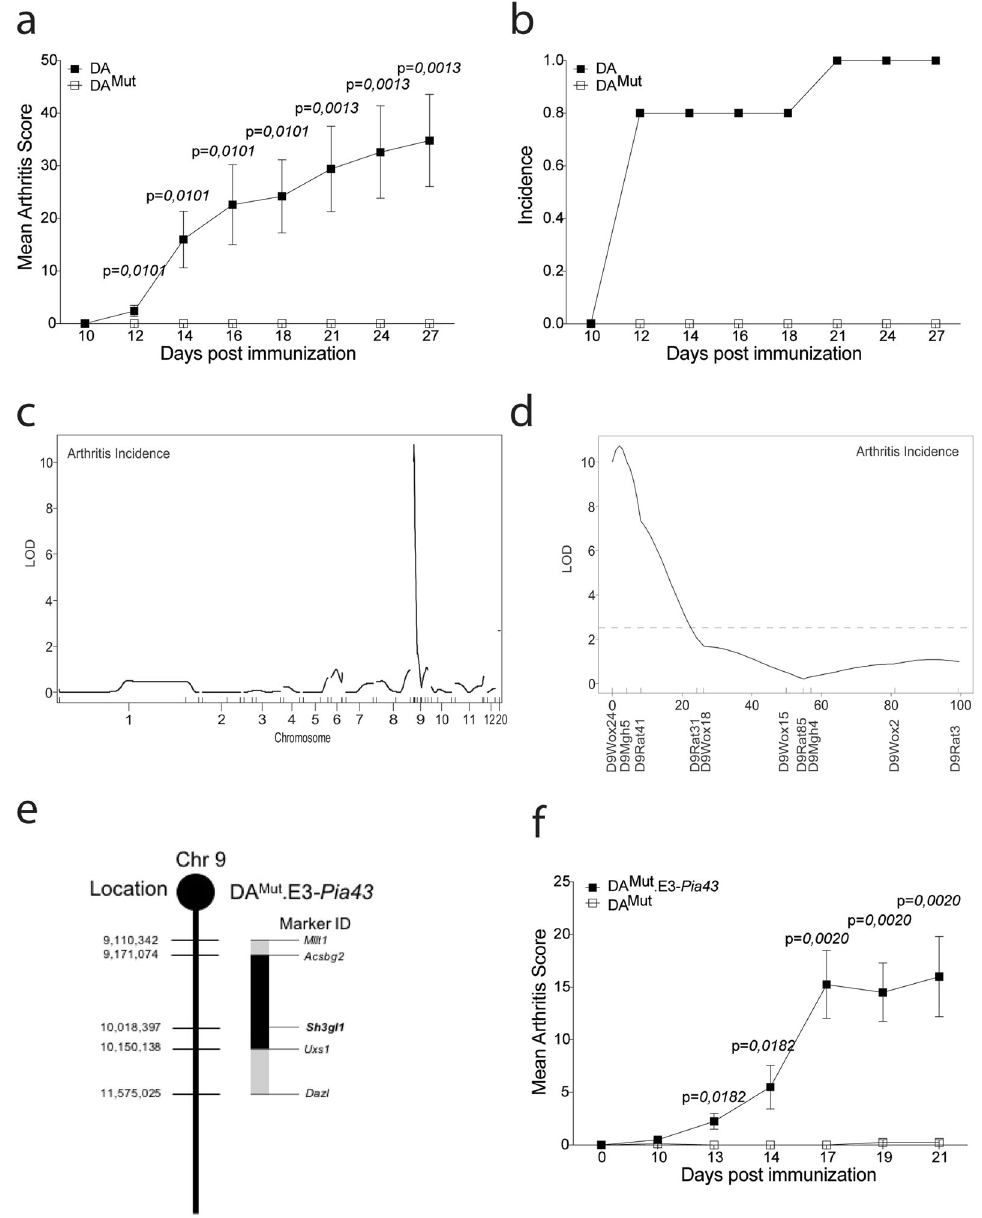
Fig. 1 Arthritis regulating loci in the DA Mut rat is restricted to a 2-Mb region on chromosome 9. a Mean arthritis score after pristane-induced arthritis in 5 DA and 7 DA Mut rats. The arthritis data has been reproduced three times with the same results. b Incidence of arthritis after pristane-induced arthritis in DA and DA Mut rats. c LOD score plot for incidence of PIA in 51 (E3.DA- Pia457 x DA Mut ) x DA Mut rats of all genotyped chromosomes. d LOD score plot for incidence of PIA in (E3.DA- Pia457 × DA Mut ) DA Mut rats on chromosome 9, broken line at 2.63 indicate signi fi cant linkage e Schematic fi gure of the DA Mut . E3- Pia43 congenic fragment on chromosome 9 with location of the SH3gl1 gene. Microsatellite markers in the Acsbg2 and Uxs1 genes indicate inner border of congenic fragment and markers Mllt1 and Dazl indicate outer borders. f Mean arthritis score after pristane-induced arthritis in 8 DA Mut and 4 DA Mut E3- Pia43 heterozygote littermates. Arthritis has been reproduced in several different congenic fragments with the same results. Non-parametrical Mann – Whitney U test was used for statistical evaluation of data. Data are presented as mean with error bars indicating ± SEM with each dot representing an individual